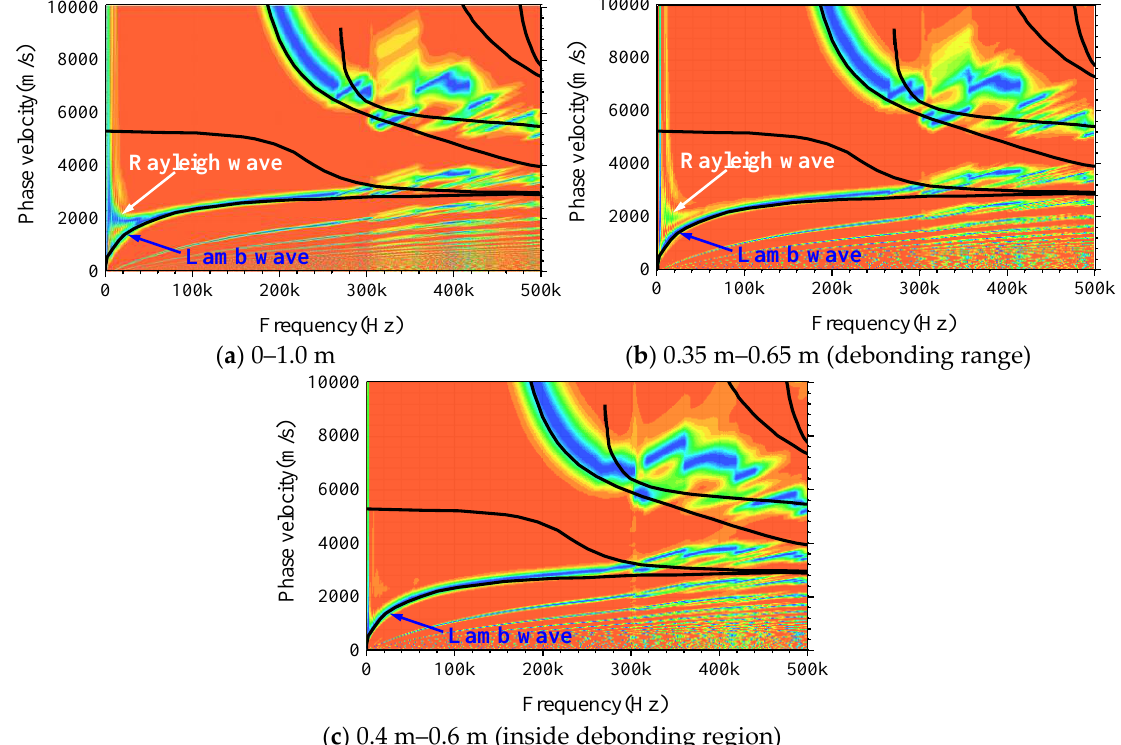
Figure 13. The comparison of dispersion curves with different measuring intervals.